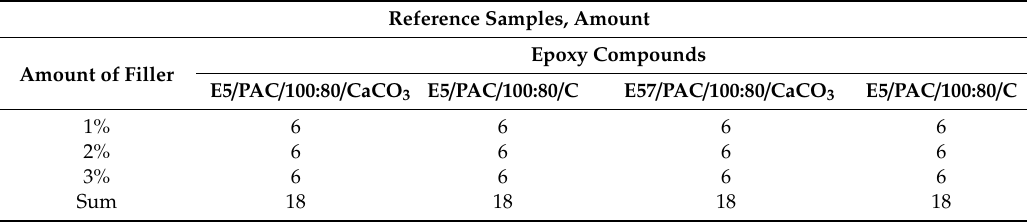
Table 3. Number of reference specimens.